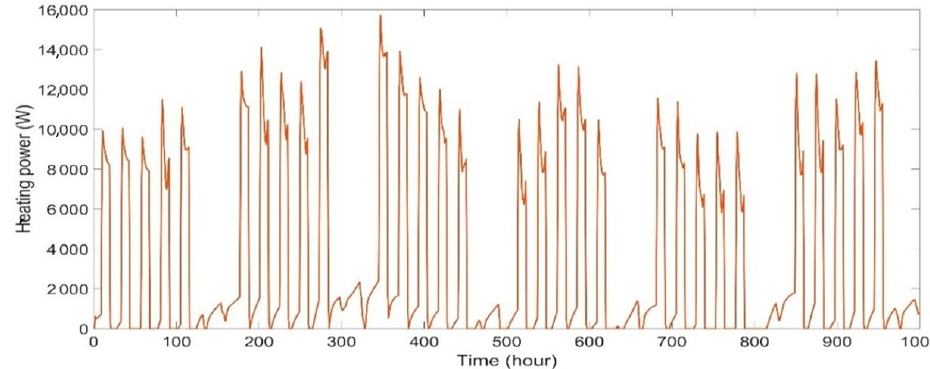
2 building simulated in TRNSYS.